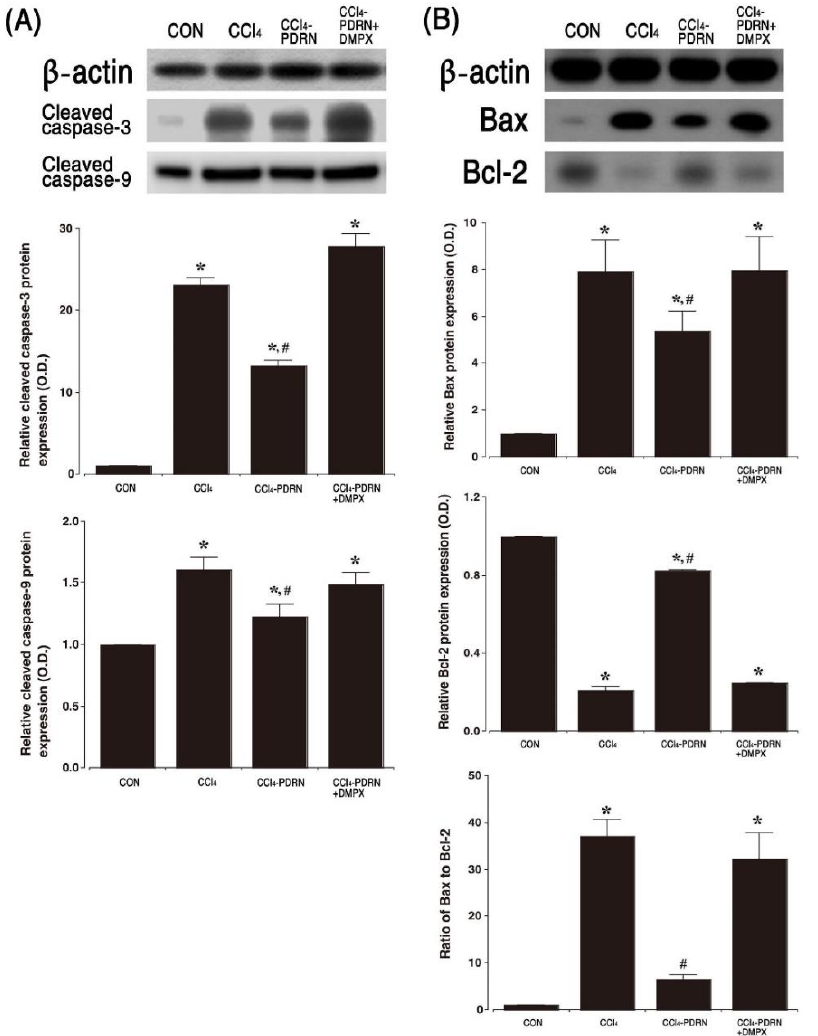
Figure 6. Cell death by apoptosis in liver tissue. ( A ) Representative expression of cleaved caspase-3 and cleaved caspase-9 in liver tissue. ( B ) Relative ratio of Bcl-2-associated X protein (Bax) to B-cell lymphoma-2 (Bcl-2) in liver tissue. CON, control group; CCl 4 , CCl 4 -injection group; CCl 4 -PDRN, CCl 4 -injection and polydeoxyribonucleotide (PDRN)-treated group; CCl 4 -PDRN + DMPX, CCl 4 -injection and PDRN with 3,7-dimethyl-1-propargylxanthine (DMPX)-treated group. * indicates p < 0.05 when compared with the control group. # indicates p < 0.05 when compared with the CCl 4 -injection group.